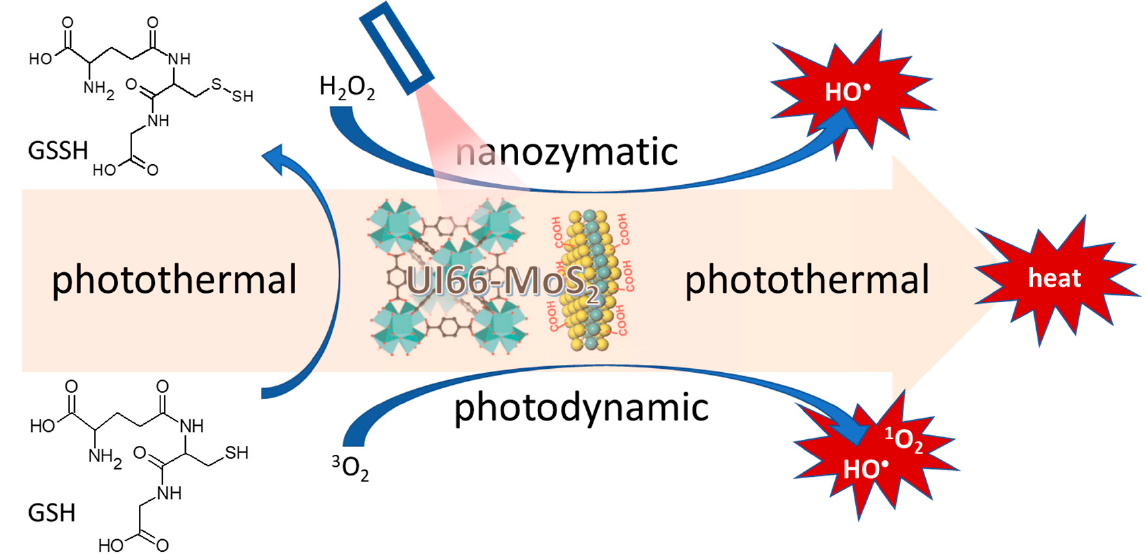
Figure 6. Nanozyme, photothermal, photodynamic, and glutathione oxidation activity of molybdenum disulfide sheet conjugated UIO-66 metal-organic-framework [167].